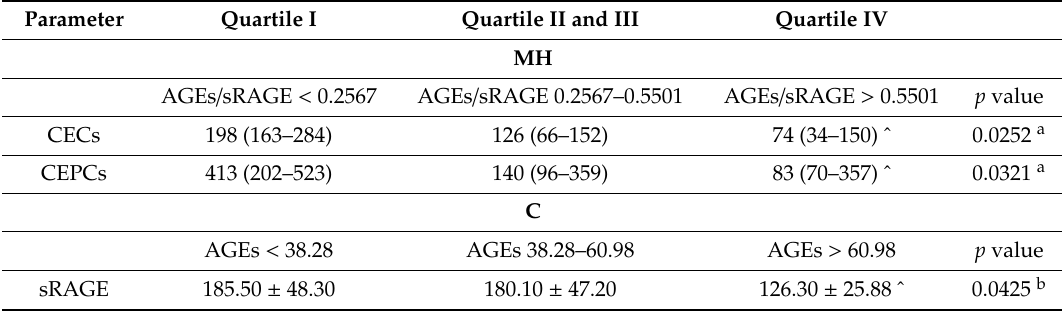
Table 1. Comparison between patients categorized into quartiles according to AGEs, sRAGE, and the AGEs / sRAGE ratio.